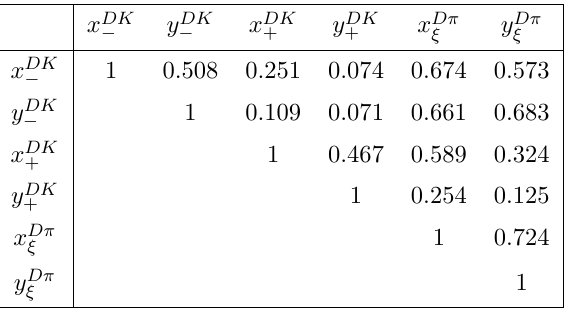
Table 9 . Experimental systematics correlation matrix obtained for the Belle standalone data